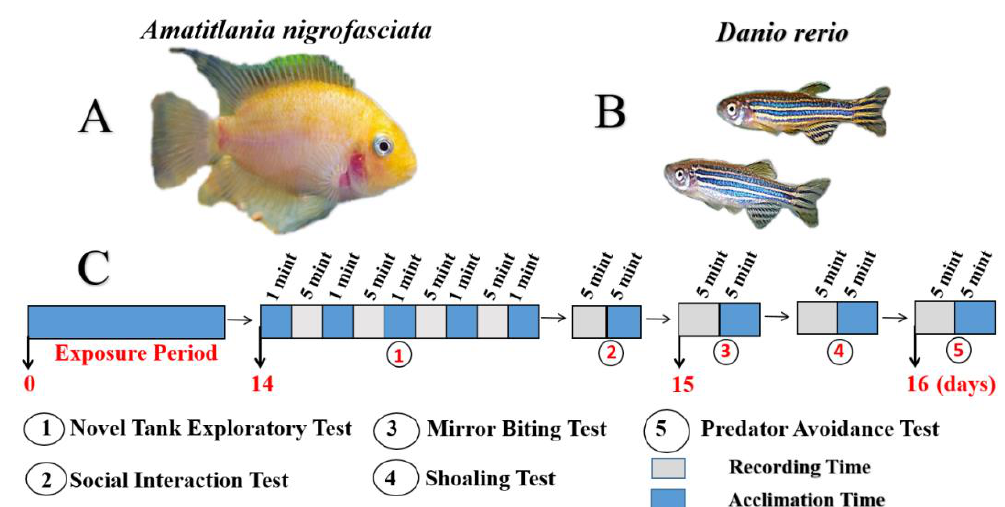
Figure 1. Experimental design for Paclobutrazol (PBZ) toxicity test in zebrafish by multiple behavior analysis. ( A ) The convict cichlid ( Amatitlania nifrofasciata ) was used as predator fish. ( B ) The AB strain zebrafish used in this study. ( C ) Five major behavior tests were performed after the adult zebrafish were exposed to PBZ at different concentrations (100 µg/L and 1000 µg/L) for fourteen-days. At 14 days post-experiment, novel tank, and social interaction assays were performed. At 15 days post-